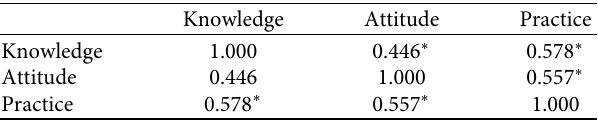
Table 7: Spearman correlations among knowledge, attitude, and practice